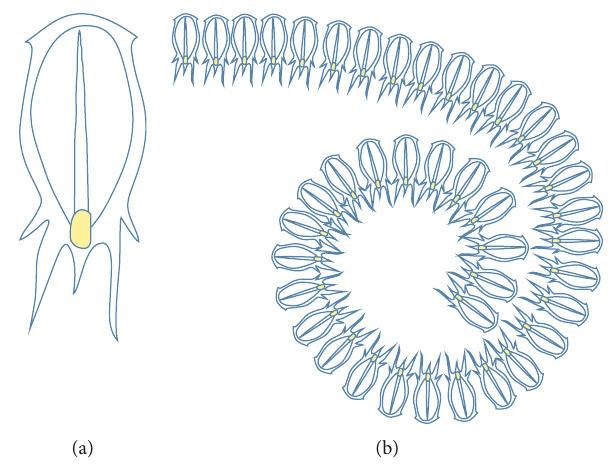
Figure 1: (a) Individual Salp. (b) Salps chain